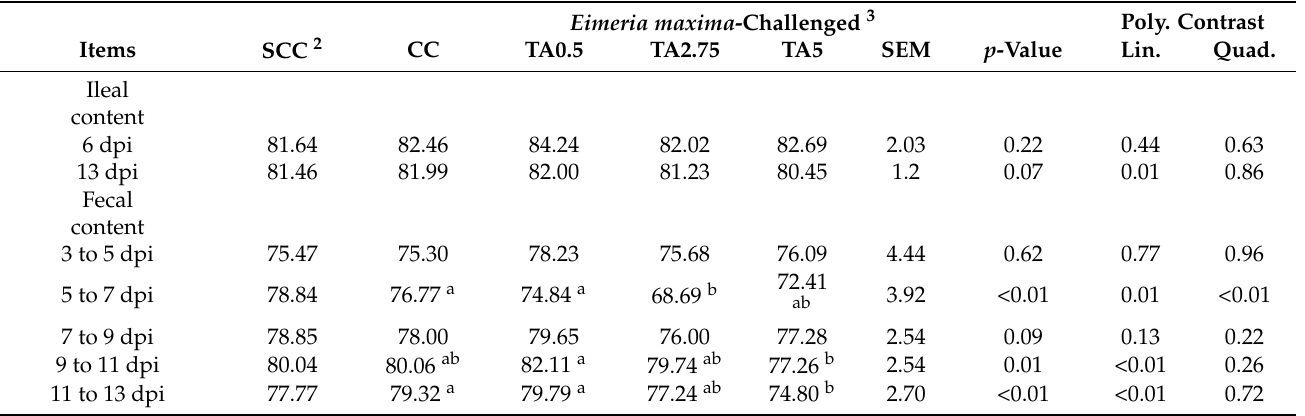
Table 4. Effects of tannic acid supplementation on ileal and fecal moisture content (%) of broilers infected with Eimeria maxima at 6 and 13 days post-infection (dpi) for ileal samples and 3 to 5 dpi, 5 to 7 dpi, 7 to 9 dpi, 9 to 11 dpi, and 11 to 13 dpi for fecal samples 1 . Eimeria maxima -Challenged 3 Poly. Contrast Quad.